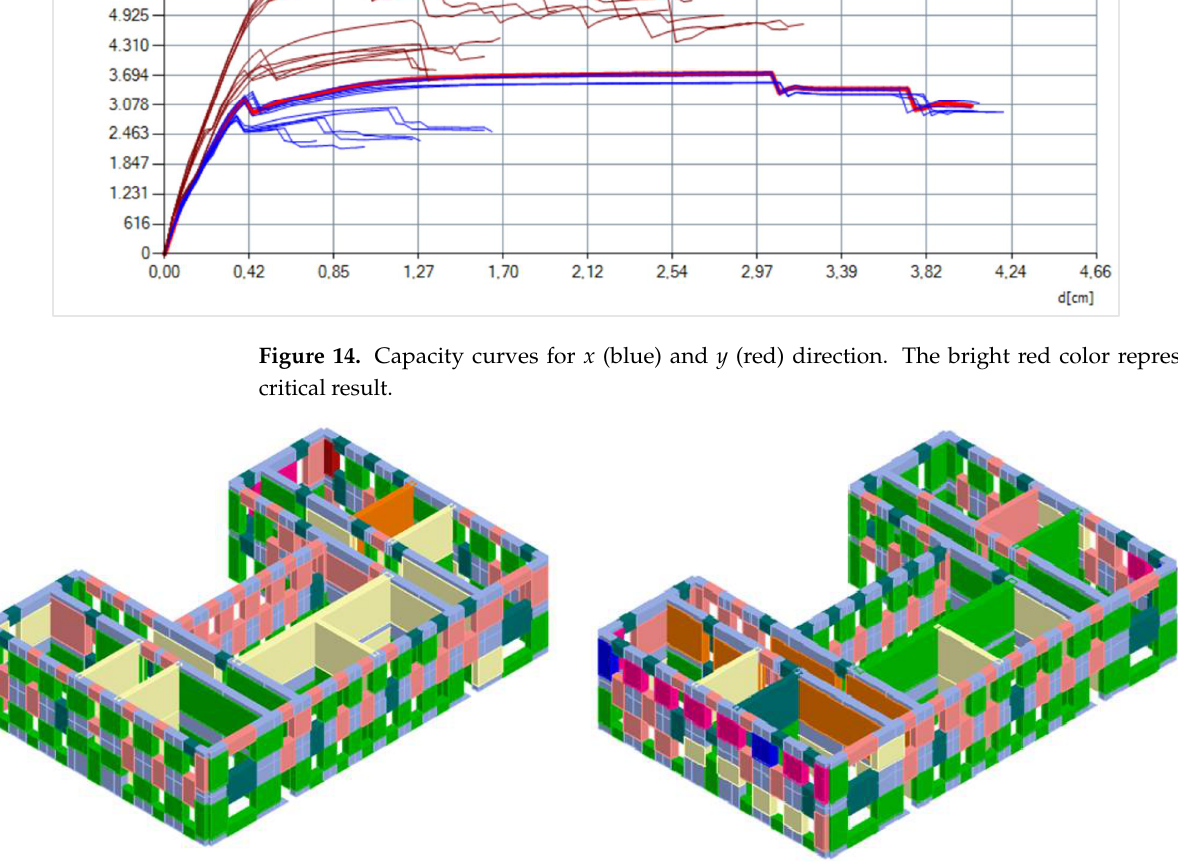
Figure 14. Capacity curves for x (blue) and y (red) direction. The bright red color represents a critical result.